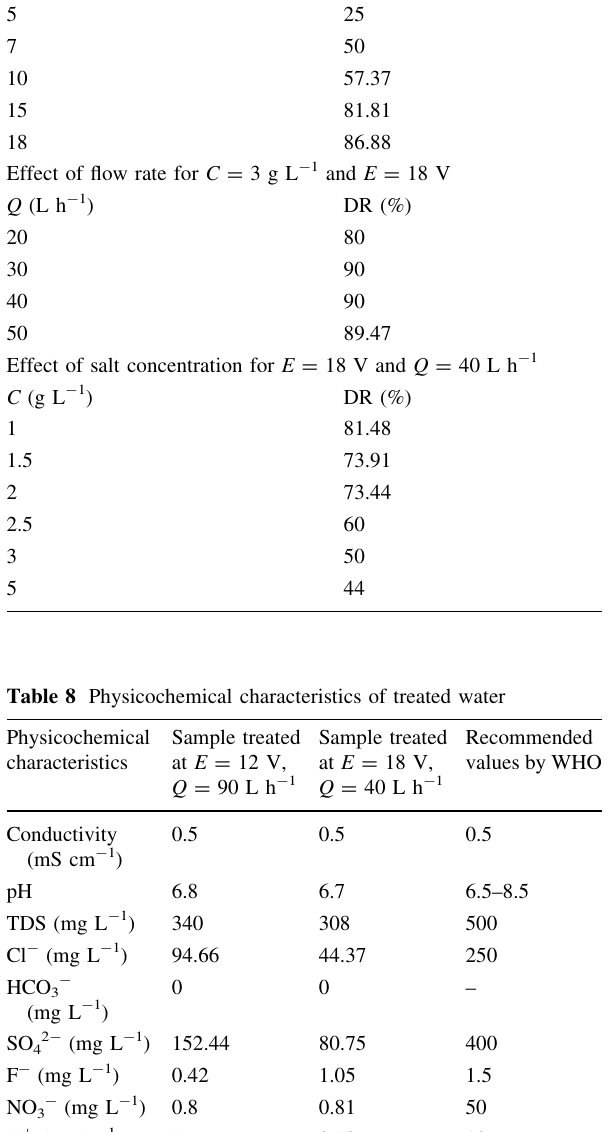
SO 42 - (mg L - 1 ) 152.44